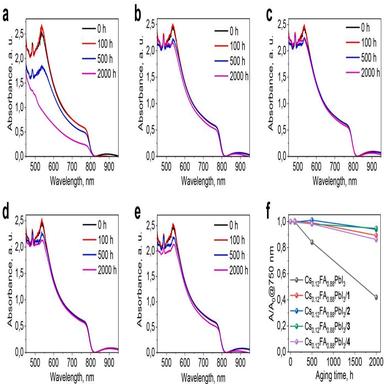
Light-induced evolution of UV–vis absorption spectra of thin films of Cs0.12FA0.88PbI3 (a), Cs0.12FA0.88PbI3/1 (b), Cs0.12FA0.88PbI3/2 (c), Cs0.12FA0.88PbI3/3 (d) and Cs0.12FA0.88PbI3/4 (e) stacks. The normalized absorbance (At/A0) at 750 nm for pristine perovskite films and Cs0.12FA0.88PbI3/ETL stacks under continuous light soaking.